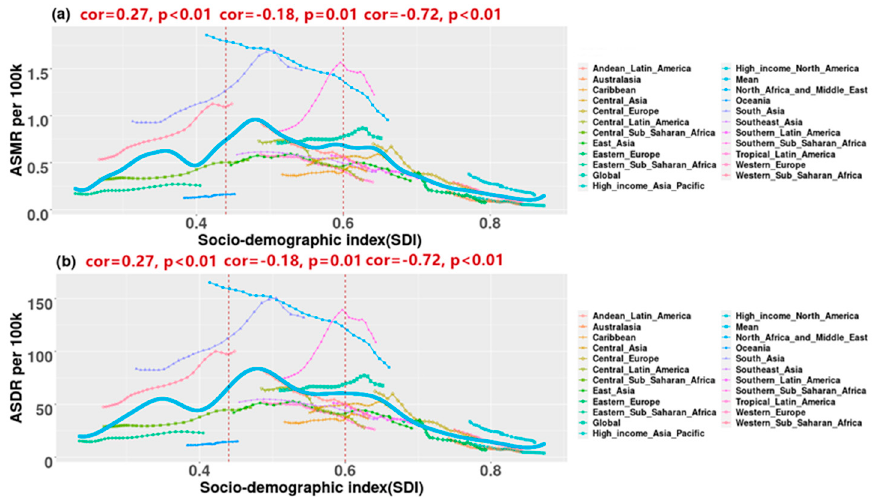
Figure 2. The trends between global and regional burden of PM 2.5 -related preterm birth and socio- demographic index (SDI) from 1990 to 2019: ( a ) age-standardized mortality rates (ASMR); ( b ) age- standardized disability-adjusted life years rates (ASDR). The U-shape solid blue line represents the expected mean value of the burden. Pearson correlation coefficient and p -value are used to reflect the trends in each part.